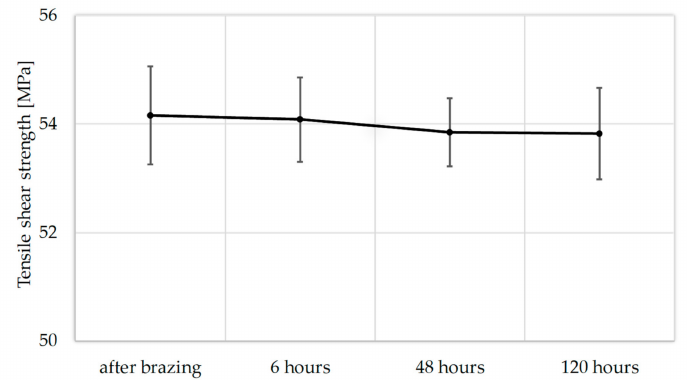
Figure 3. Tensile shear strength of brazed joints depending on the thermal exposure (200 ◦ C) .